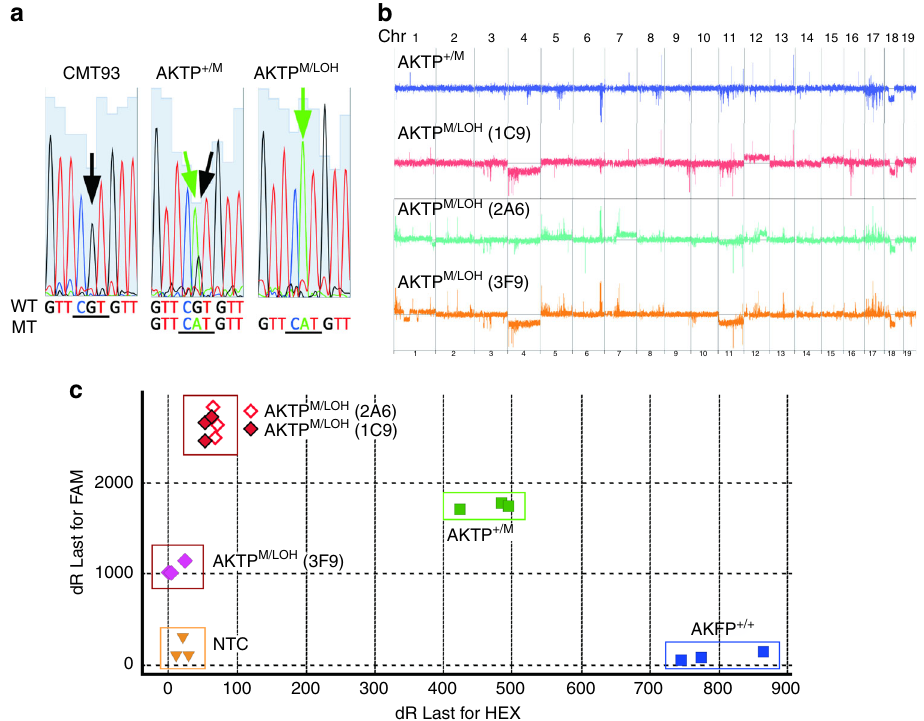
Fig. 3 Mechanism underlying Trp53 LOH in AKTP + /M cells. a Direct sequencing of genomic DNA fragments including codon 270 (under line) of Trp53 in CMT93 cells, AKTP + /M , and AKTP M/LOH cells. WT, wild-type Trp53 ; and MT, mutant Trp53 (R270H). b A whole-genome CGH analysis of the indicated AKTP M/LOH subclones (1C9, 2A6, and 3F9) and parental AKTP + /M cells. Chr indicates chromosome number. c TaqMan SNP genotyping results of AKTP M/LOH 2A6 cells (open diamonds with red line), AKTP M/LOH 1C9 cells (red diamonds with black line), AKTP M/LOH 3F9 cells (magenta diamonds), AKTP + /M cells (green squares), AKTP + / + cells (blue squares), and no template control (NTC) (yellow triangles) are shown as a scatter plot. The Trp53 allelic discrimination data are shown as a scatter plot of Trp53 wild-type codon 270 (CGT) (HEX dye) versus Trp53 mutant codon R270H (CAT) (FAM dye). Note that two AKTP M/LOH subclones (2A6 and 1C9) carry two copies of mutant Trp53 R270H, while one AKTP M/LOH subclone 3F9 carries one copy or Trp53 R270H. Source data are provided as a Source data fi